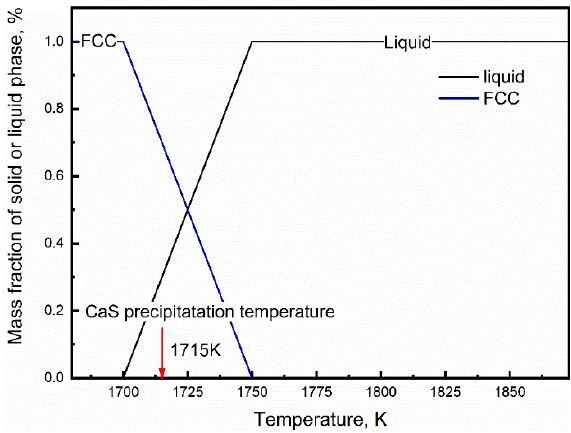
Figure 13. Change of phase fraction with solidification.